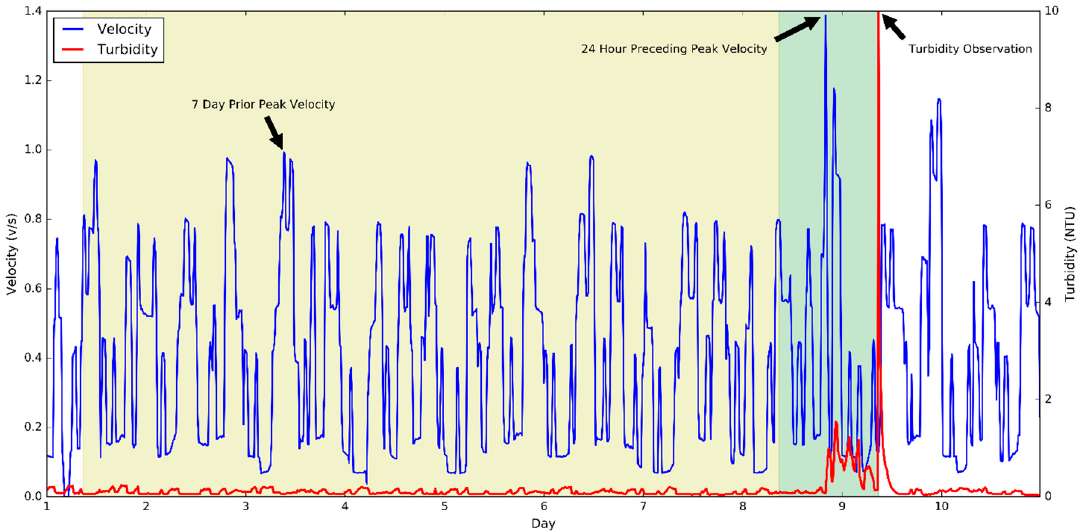
Figure 1. An example of the methodology showing that the turbidity observation could be linked to the preceding upstream hydraulic mobilisation of discolouration material. The 24 h preceding the turbidity observation are highlighted green, and the 7 prior days are highlighted yellow. The preceding 24-h peak velocity is shown to be the cause of the high turbidity observation as it exceeds the prior 7-day peak velocity. NTU: Nephelometric Turbidity Units.